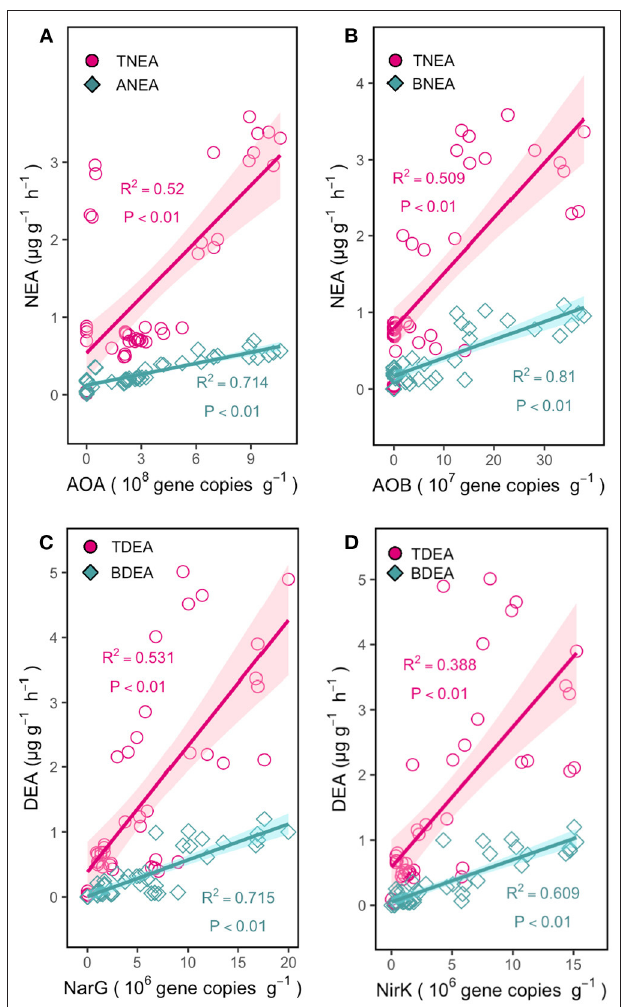
FIGURE 2 | Relationships between the abundance of AOA and TNEA or ANEA (A) ; AOB and TNEA or BNEA (B) ; narG and TDEA or BDEA (C) ; nirK and TDEA or BDEA (D) in grassland soils. The R 2 values are the coefficients of